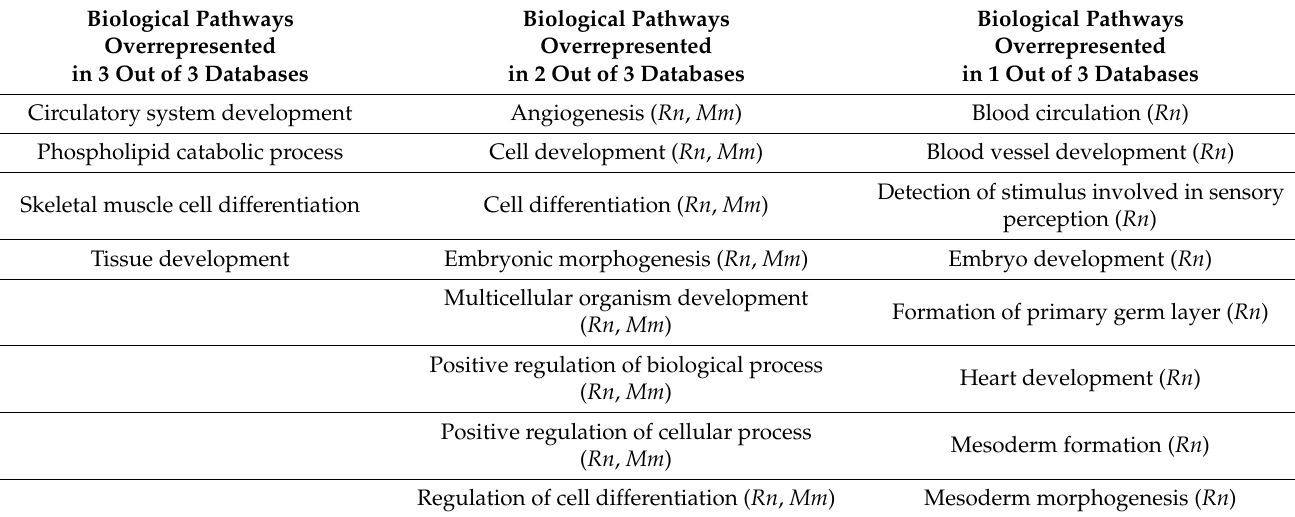
Table 2. Selected “biological process” terms significantly overrepresented solely in Fil050G at 10 days of implantation in the Homo sapiens ( Hs ), Mus musculus ( Mm ), and Rattus norvegicus ( Rn )